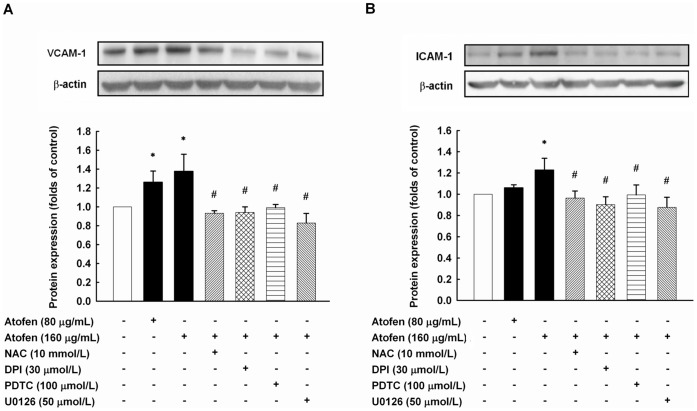
Iron upregulated the expressions of VCAM-1 and ICAM-1 in HAECs.The expressions of VCAM-1 (A) and ICAM-1 (B) in iron-stimulated HAECs were determined by Western blotting. HAECs were treated with ferric chloride hexahydrate (Atofen) with or without NAC (100 mmol/L), DPI (30 µmol/L), PDTC (100 µmol/L), and U0126 (50 µmol/L) for 4 hours. Data (mean ± SEM) are shown as a bar graph of densitometry data from 3 separate experiments. *P<0.05 compared with baseline without any treatment. #
P<0.05 compared with 160 µg/mL ferric chloride hexahydrate for 4 h. Abbreviations: DPI, diphenyleneiodonium; HAECs, human aortic endothelial cells; ICAM-1, intracellular cell adhesion molecule-1; NAC, N-acetylcysteine; PDTC, pyrrolidine dithiocarbamate; VCAM-1, vascular cell adhesion molecule-1.